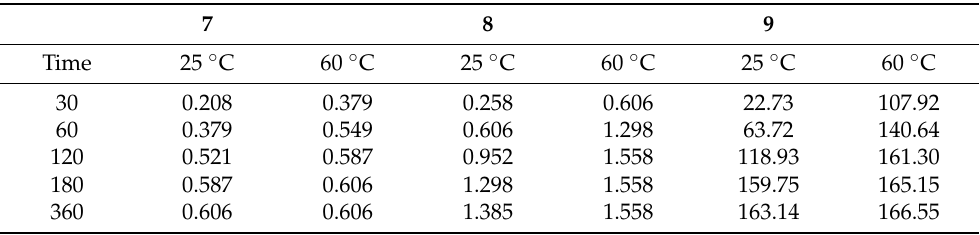
Table 3. Average adsorbed iodine (mg g − 1 ) for complexes 7 – 9 at different time intervals (min) and temperatures.